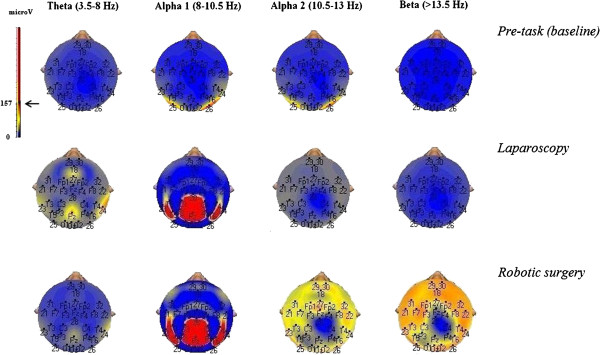
Power spectrum maps of the same surgeon in a resting condition (pre-task, top row) and performing the motor task with either a conventional laparoscopic (middle row) or a robotic (bottom row) modality. Note the larger representation of upper alpha and beta frequencies when a robotic approach was used.